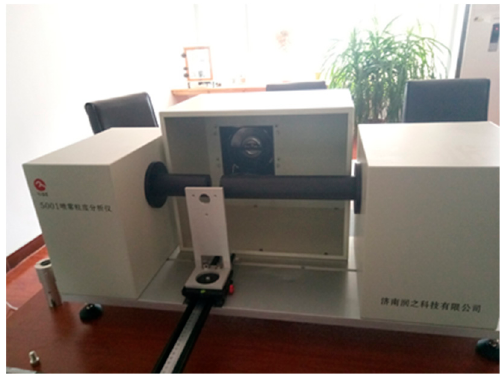
Figure 11. Spray particle size test bench.